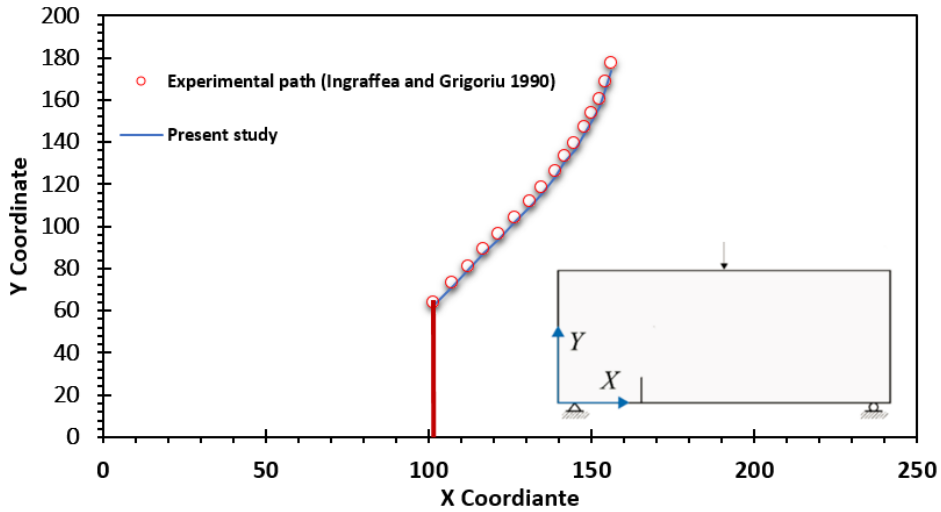
Figure 21. Crack tip coordinates comparison for specimen 6.